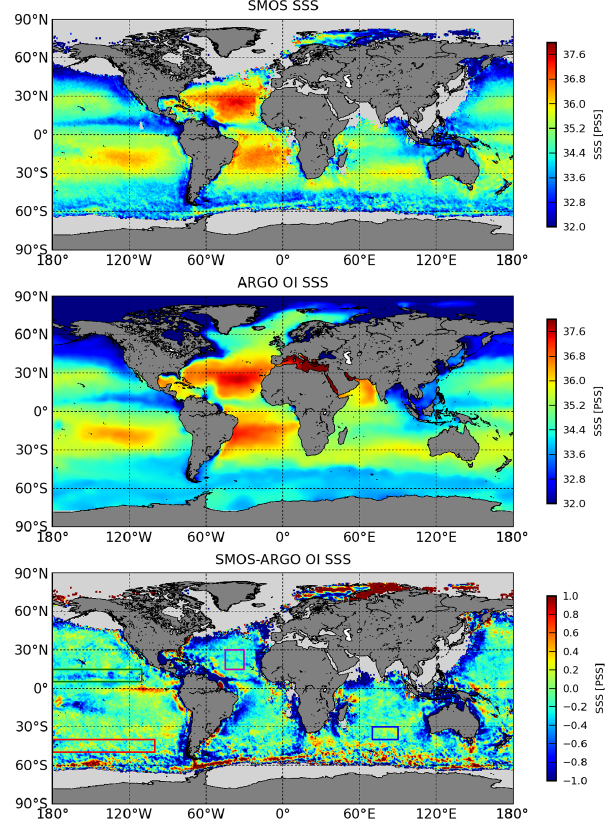
Fig. 1. Maps of SSS averaged from July to September 2010, derived from (top) SMOS ascending orbits, (middle) ARGO OI, SMOS- ARGO OI (bottom) Difference between SMOS and ARGO OI maps. Color rectangles indicate regions where precise comparisons with ARGO have been